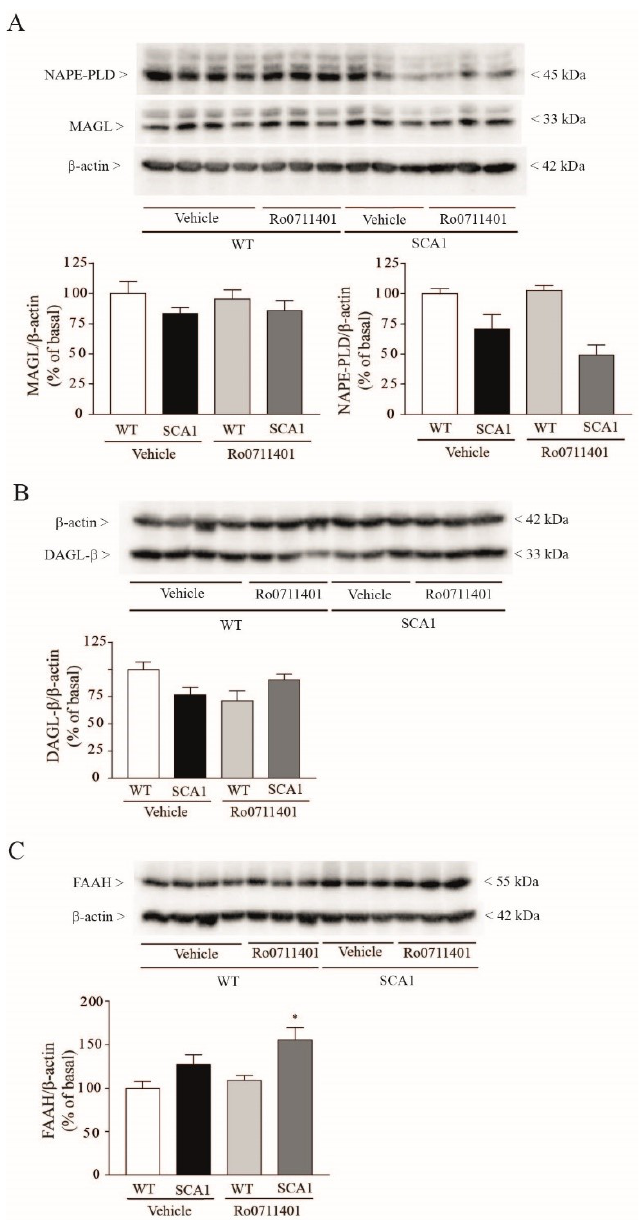
Figure 6. Changes in hippocampal protein levels of NAPE-PLD and FAAH in SCA1 mice treated with Ro0711401. Reduced hippocampal levels of the AEA synthesizing enzyme, NAPE-PLD, in SCA1 mice treated with Ro0711401 are shown in ( A ), while increased levels of the AEA-degrading enzyme, FAAH, are shown in ( C ), as compared to wild-type mice treated with vehicle or Ro0711401. Hippocampal levels of MAGL and DAGL-β did not differ between the two genotypes and were not affected by Ro0711401 treatment ( A, B ). * p < 0.05 vs. the respective values obtained in wild-type mice. Statistical analysis was performed by two-way ANOVA + Bonferroni test values are means ± SEM of 4–5 mice. In ( A ): genotype, F1,15 = 24.01, p = 0.0002; treatment, F 1,15 = 1.216, p = 0.2876; interaction, F 1,15 = 2.038, p = 0.1739. In ( C ): genotype, F 1,15 = 12.2, p = 0.0033; treatment, F 1,15 = 3.12, p = 0.0977; interaction, F 1,15 = 0.8092, p = 0.3826.